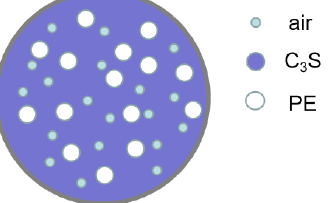
Figure 10. Schematic drawing of three-phase sample.